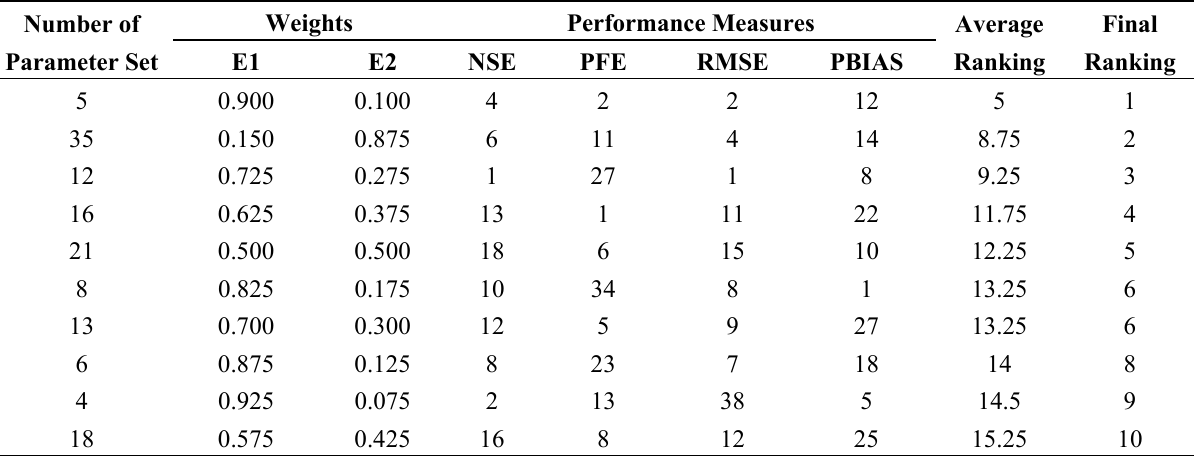
Table 5. Rankings based on four performance